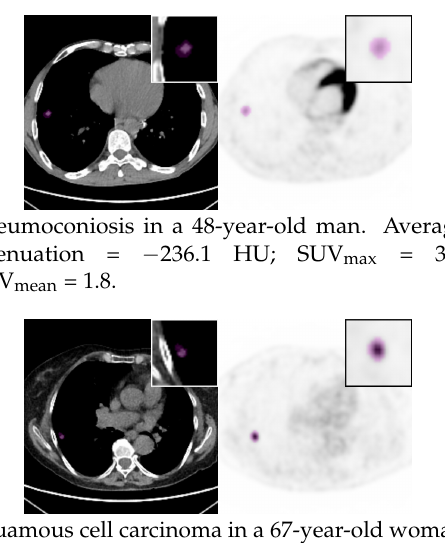
Figure 1. Sample CT and PET scans showing benign (first row) and malignant (second row) pulmonary nodules. Magnified (2 × ) views of the manually segmented lesions are shown in the insets; basic CT and PET parameters are also